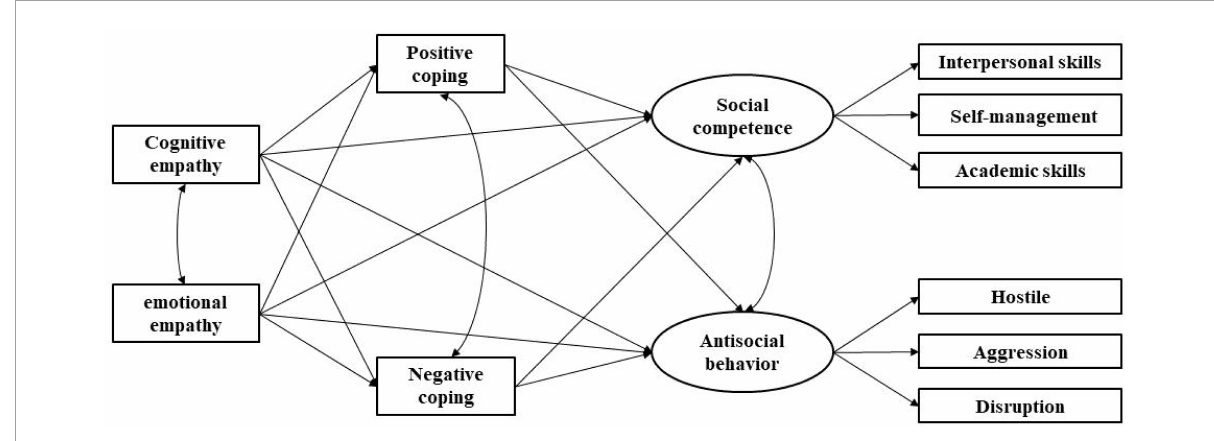
FIGURE1 Hypothesized moderated mediation model among empathy, school adjustment, and coping